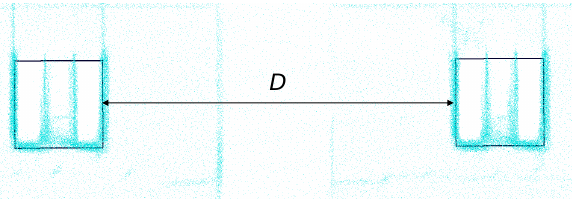
Figure 6. Vectorization of the column sections and distance measurement between adjacent columns for the handheld MMS point